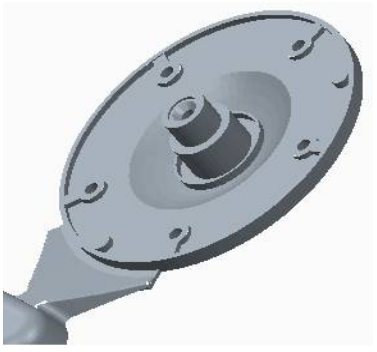
Figure 5. The melt jet is outside the core.